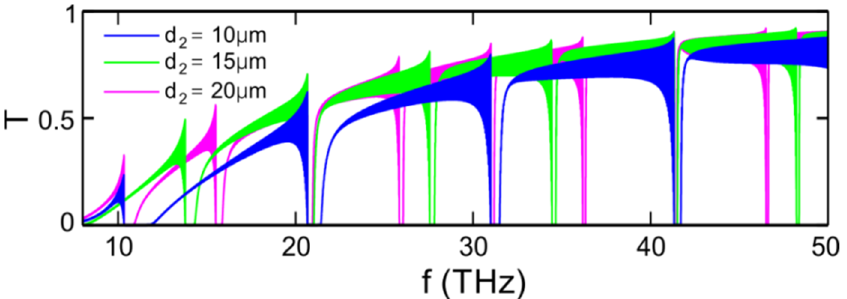
Figure 5. Transmittance varying with the frequency of light wave for different spatial intervals of two adjacent graphene pairs. The graphene chemical potential is μ = 0.4 eV, and the relaxation time is set as τ = 0.5 ps.